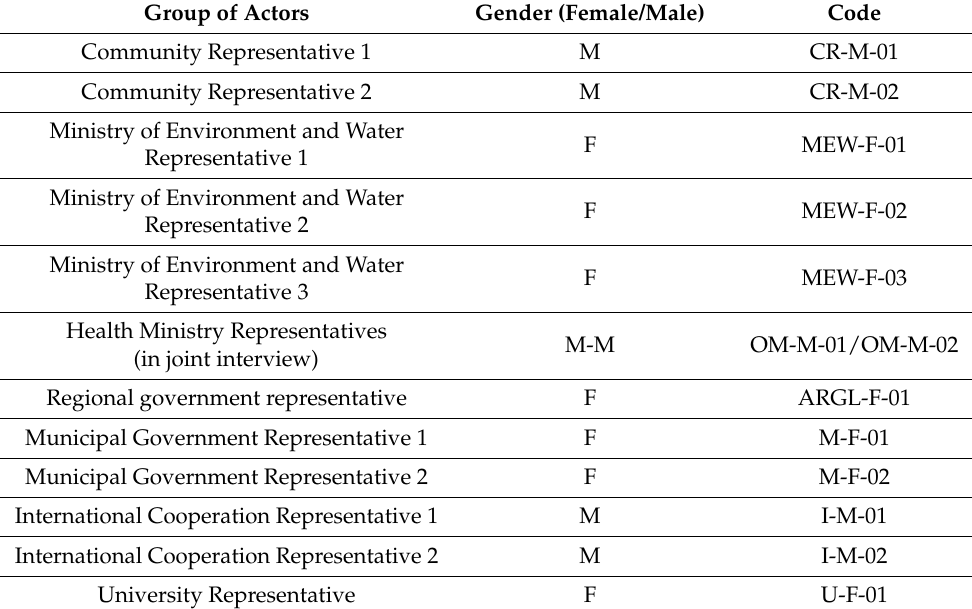
Table 2. Stakeholders